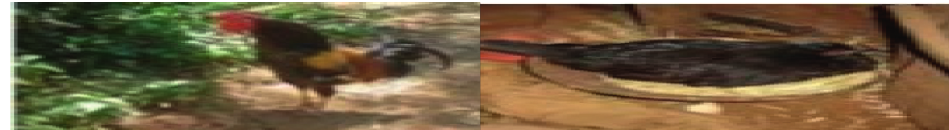
Figure 4: Black plumage color indigenous ecotypes. Source: Tamir et al., 2015.